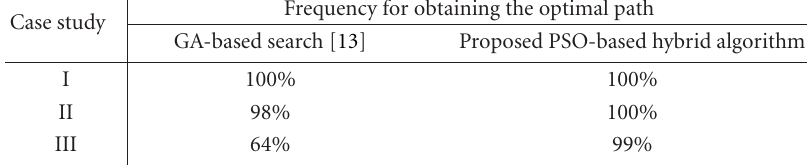
Table 4 . 4 . Comparison of statistical results between GA-based search [13] and proposed algorithm for test number 1. Case study